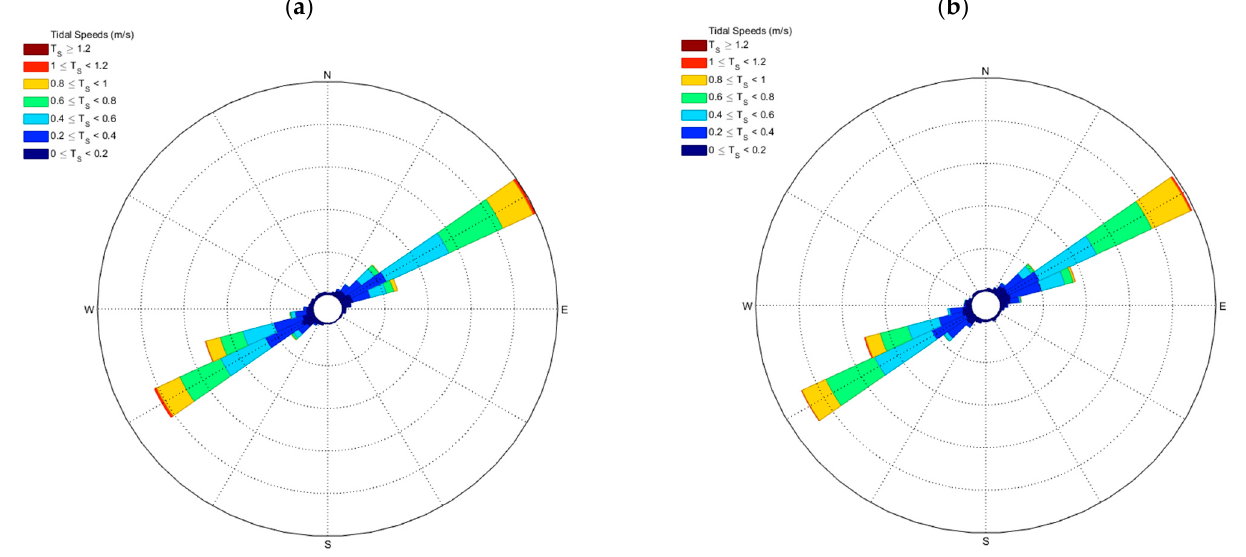
Figure 6. ( a ) ADCP measured current rose. ( b ) Network predicted current rose. Table 4. Measured mean power before accounting for the angle of current (raw power), considering incident angle (measured), and each training method’s best-performing networks prediction of mean power and error. Network Percentage Error Mean Power (Wm − 2 ) Max Power (Wm − 2 ) from Mean Measured (%) Raw power 127.72 - 904.95 Measured 127.14 - 904.82 GDA 124.03 − 2.48 928.03 126.17